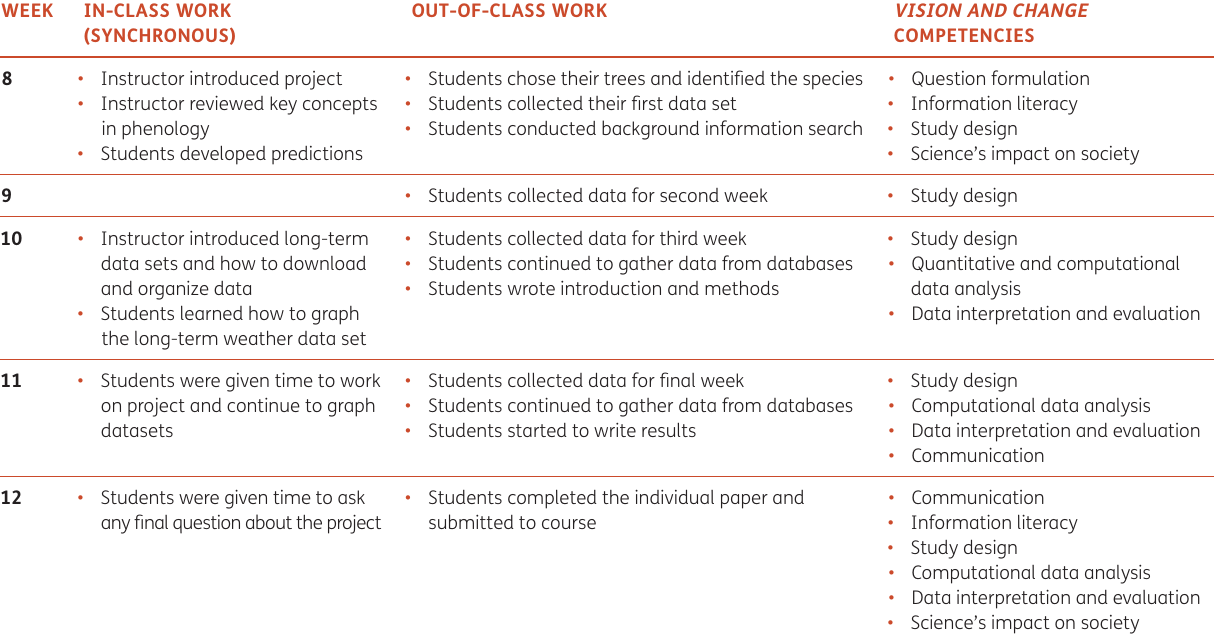
Table 1 Flow of the course during the Budburst module with the Vision and Change